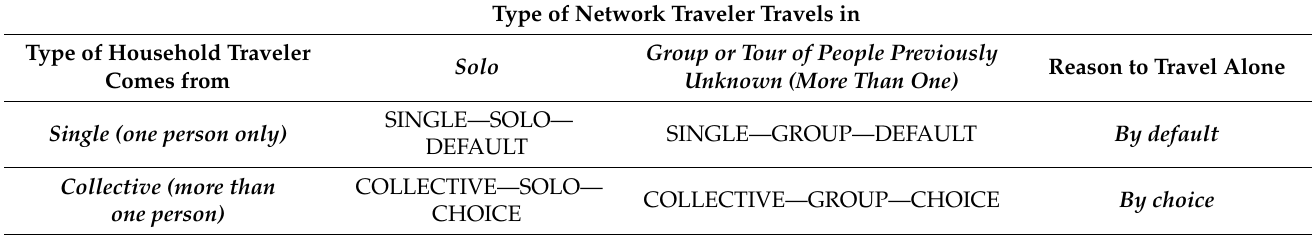
Table 5. Solo traveler